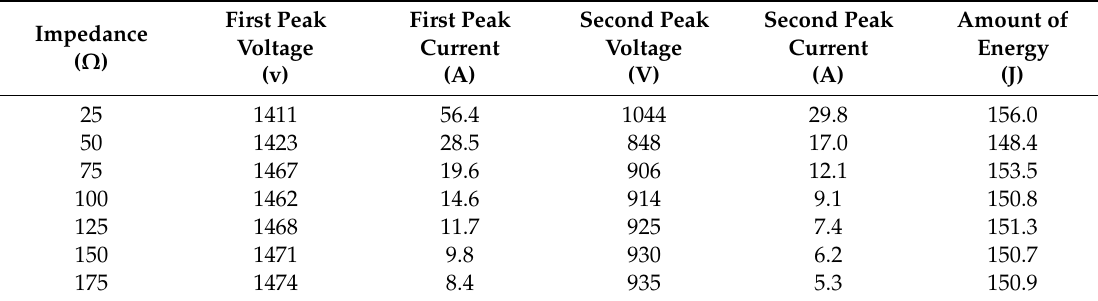
Table 2. Test result table for electric shock energy in adult mode.